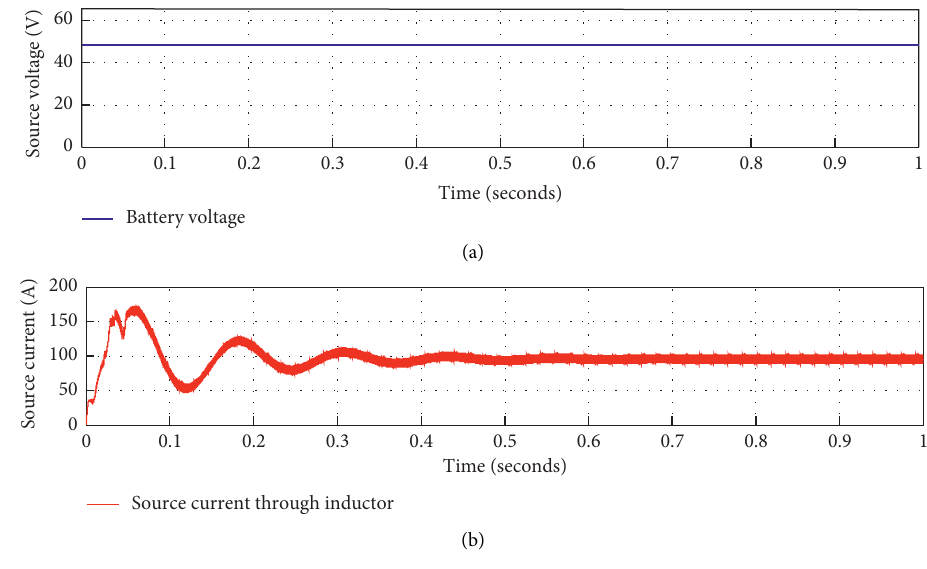
Figure 10: (a) Source voltage and (b) source